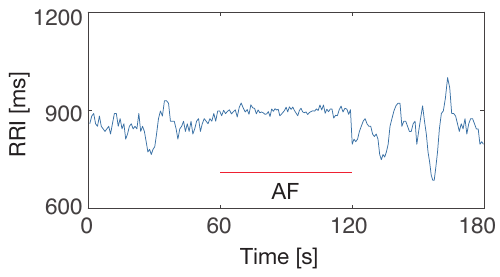
Figure 13. An example of artificial RRI data containing AF.